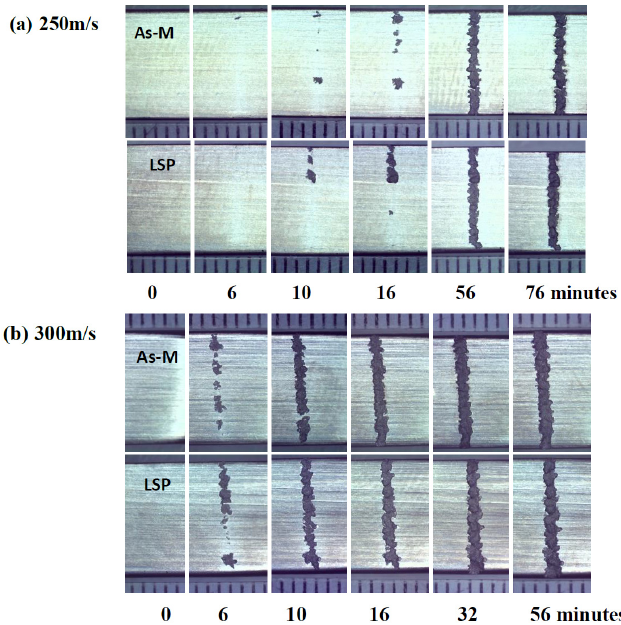
Figure 14. Optical macrographs showing the erosion evolution and progression on As-M and LSP samples tested at ( a ) 250 m/s and ( b ) 300 m/s.